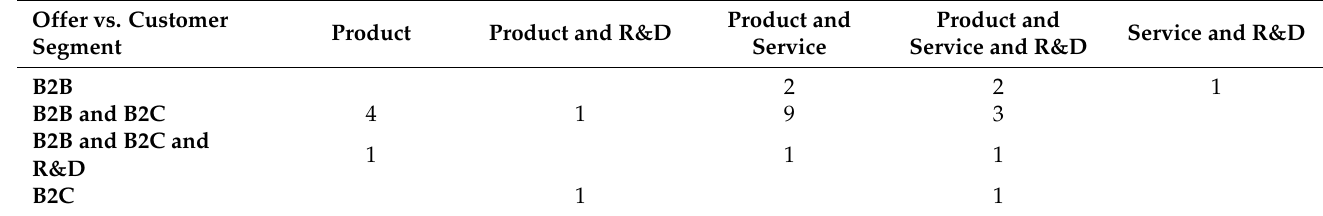
Table 1. Offers according to the customer segments of the different entities.